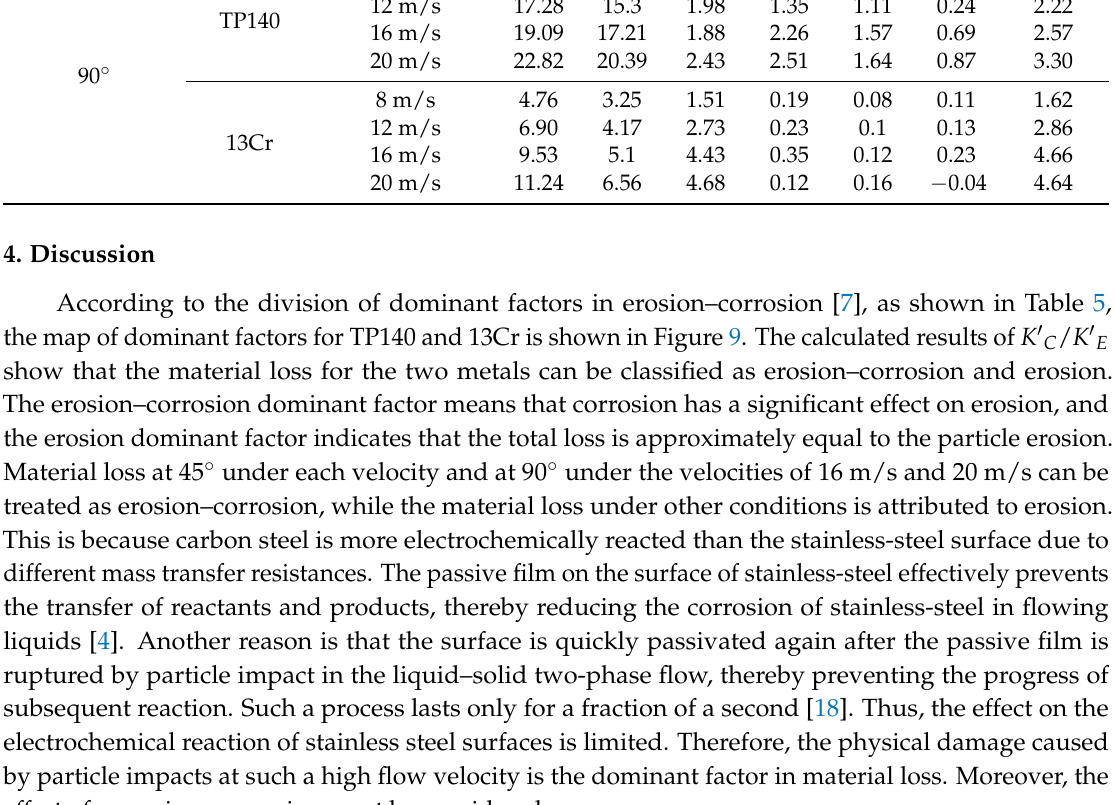
( b ) △ K E /K E Figure 10. Increased erosion and corrosion rate under liquid–solid and gas–solid or liquid flow: ( a ) increased corrosion rate; ( b ) increased erosion rate. The erosion surface is susceptible to flow-induced corrosion owing to loose material, large contact areas, and large roughness. Figure 11 shows the erosion images of TP140 at different jet angles and flow velocities. According to Figure 11a–c, the depressed area after erosion is more susceptible to corrosion than the uneroded surface. Corrosion begins to occur near the erosion craters and eventually joins into an area at an angle of 45 ° , and the erosion areas that are impacted by a large angle can be corroded from craters, platelets, and extruding lips.